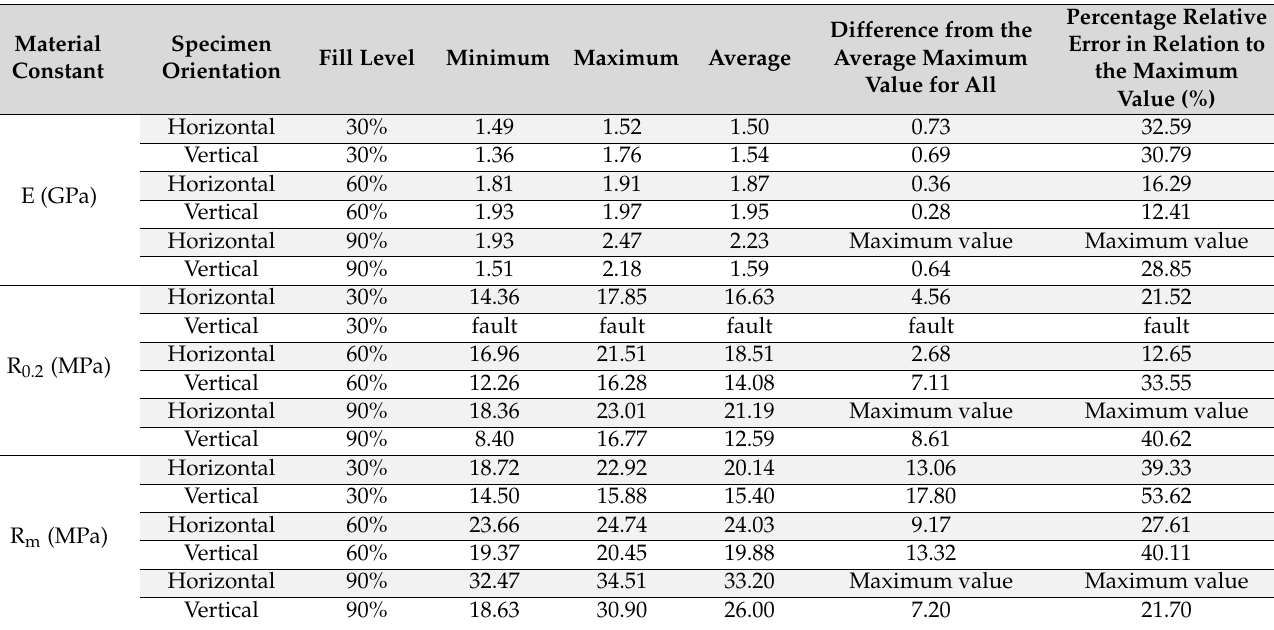
Table 10. Comparison of the mechanical properties’ values for the COLORFILL material in the uniaxial tensile